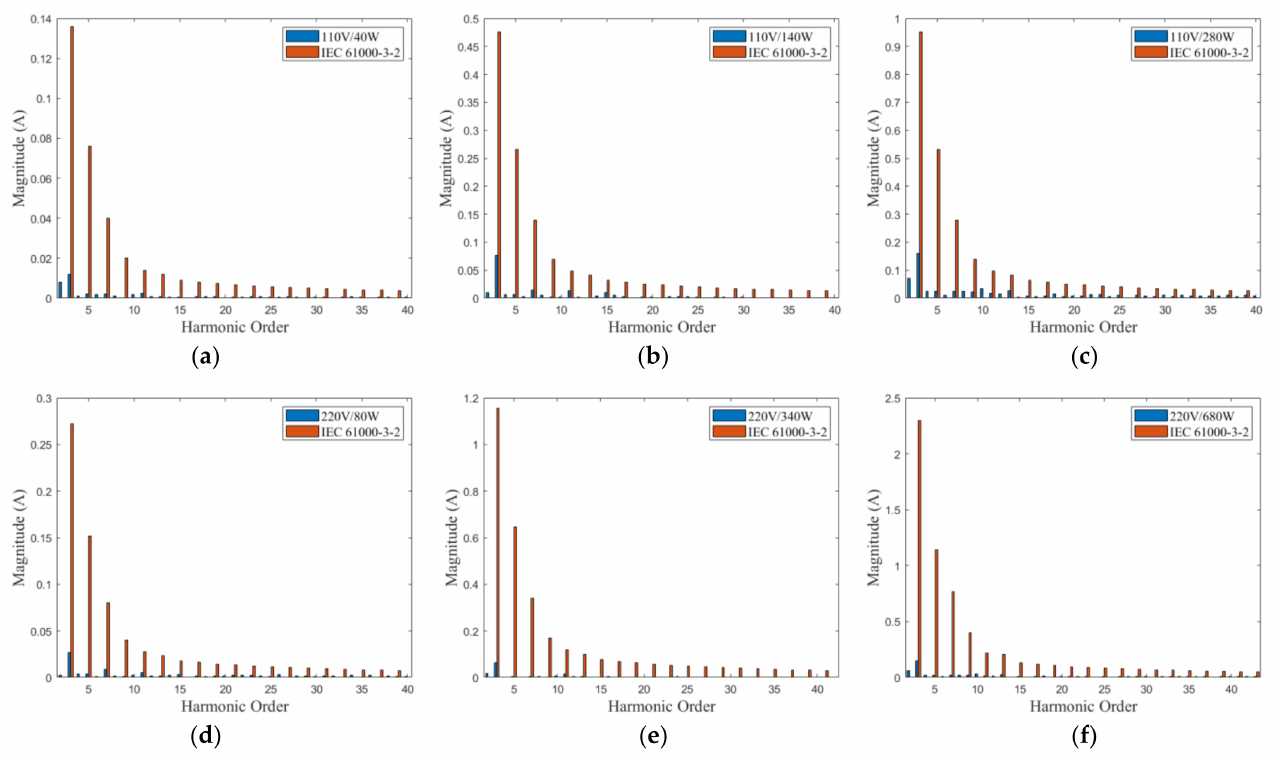
Figure 16. Harmonic spectrums of input current compared with IEC 61000-3-2 standard. ( a ) 110 VAC/40 W; ( b ) 110 VAC/140 W; ( c ) 110 VAC/280 W; ( d ) 220 VAC/80 W; ( e ) 220 VAC/340 W; ( f ) 220 VAC/680